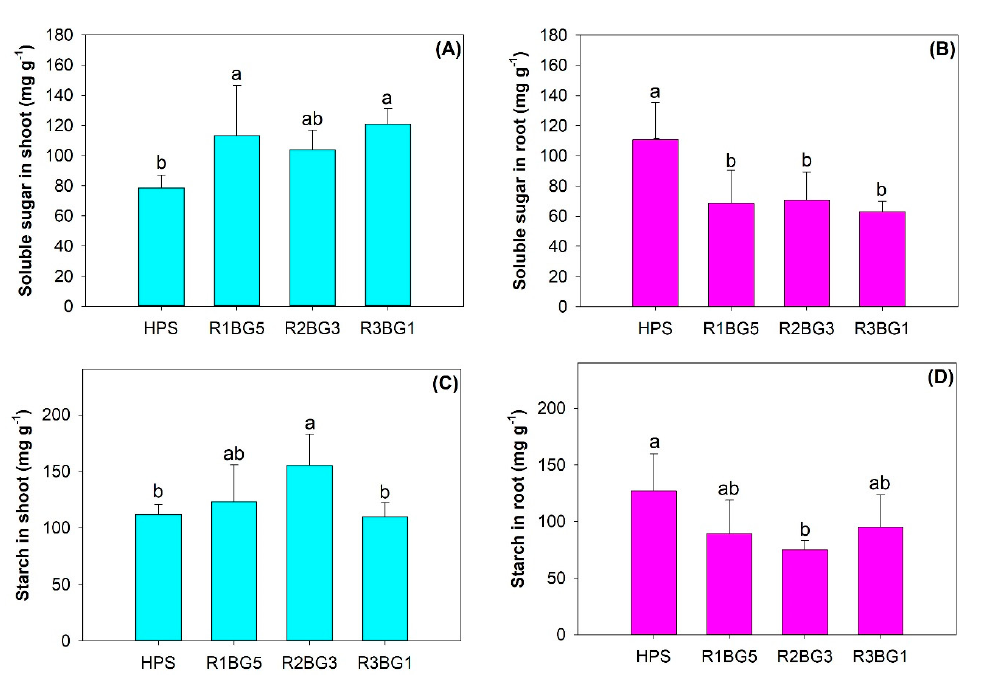
Figure 8. Concentrations of soluble sugars (top) and starch (bottom) in the shoots (left) and roots (right) of Korean pine ( Pinus koraiensis ) seedlings under three LED-spectra treatments (R1BG5, R2BG3, and R3BG1) with the HPS spectrum as the control. Di ff erent letters indicate significant di ff erence according to Tukey’s test at the 0.05 level. Subfigure A and B present soluble sugar concentration in shoot and root, respectively. Subfigure C and D present starch concentration in shoot and root,